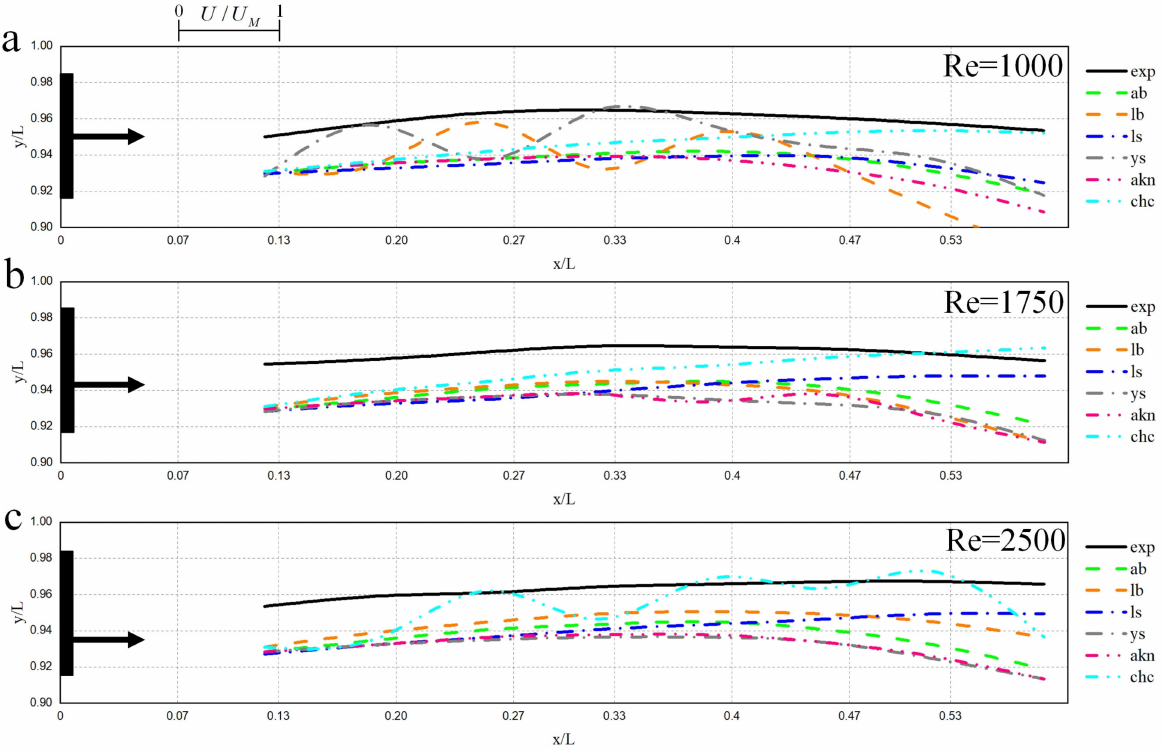
Figure 5. Comparison of the position of the maximum dimensionless x-velocities of the jet mea- sured by PIV and modeled by six low-Reynolds number k- ε models. ( a ) Re = 1000; ( b ) Re = 1750; ( c ) Re =